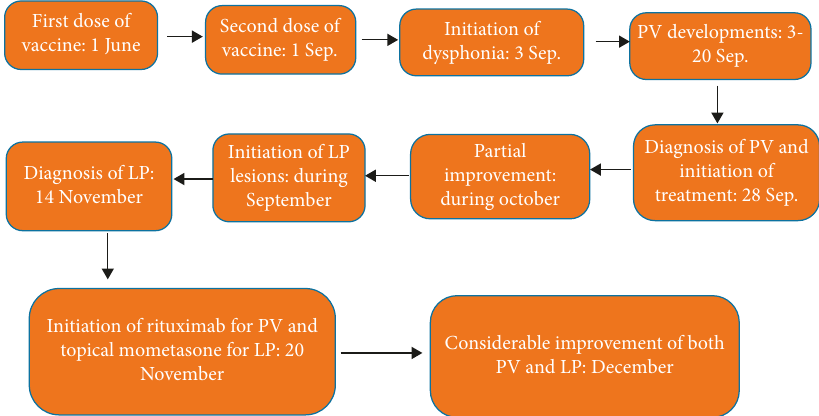
Figure 3: The exact time points of